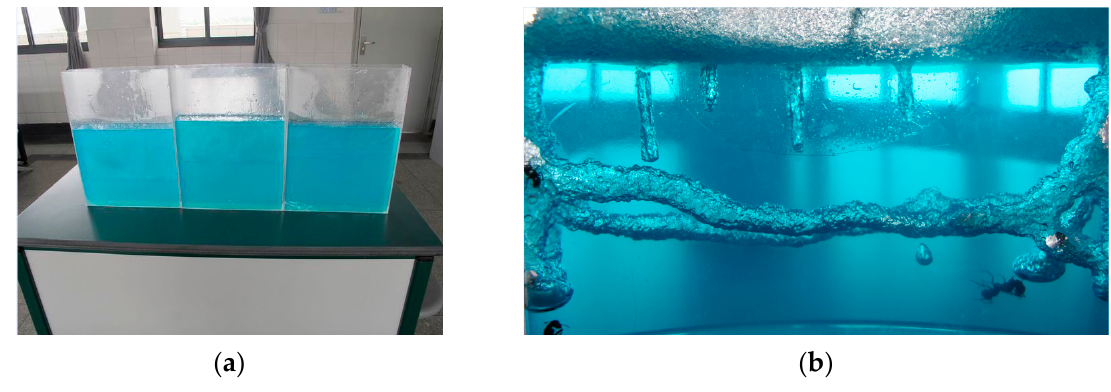
Figure 3. ( a , b ) The process of nesting construction of Camponotus japonicus.